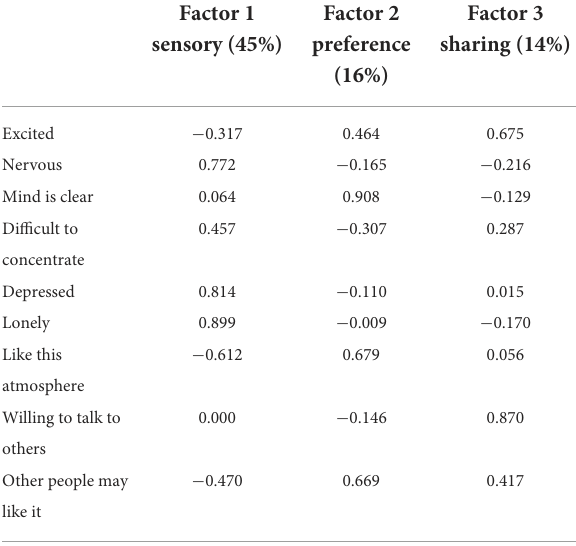
TABLE 4 Rotated component matrix of mood factor